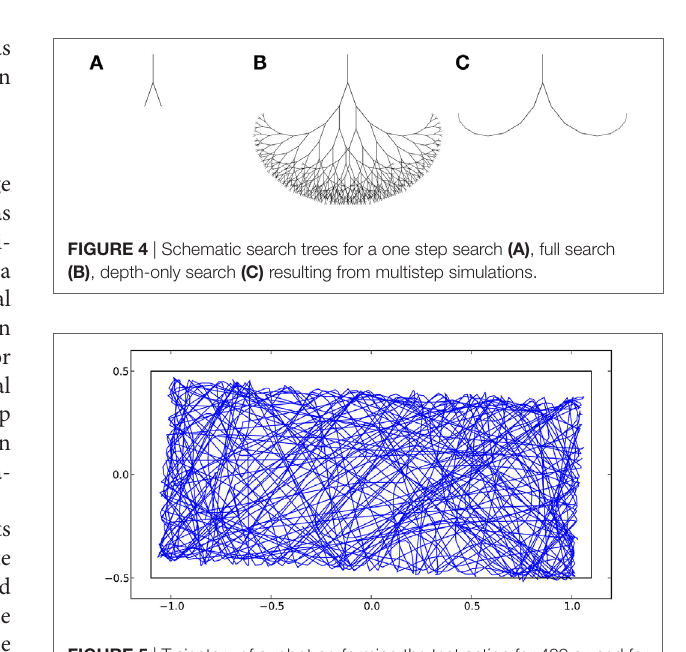
FigUre 5 | Trajectory of a robot performing the test action for 489 s used for the simulation error calibration. The measured trajectory of the robot is depicted as a blue line, and the location of the arena walls in the frame of reference of the simulation is depicted as a black line. The mismatch between the area formed by the trajectory measurements and the arena show the calibration error of 3° of the motion capturing system.